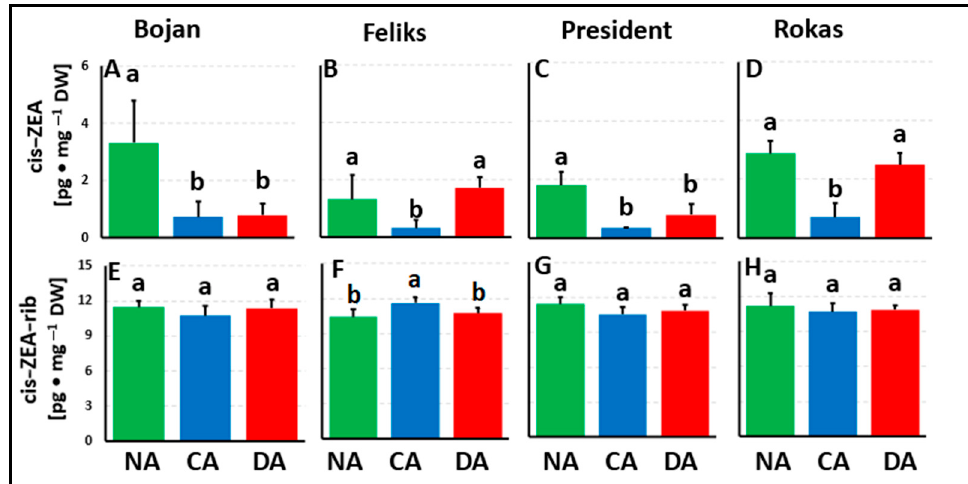
Figure 6. Content of the cytokinins–cis-zeatin (cis-ZEA) and cis-zeatin-riboside (cis-ZEA-rib) in four cultivars of the non-acclimated (NA), cold-acclimated (CA) and deacclimated (DA) oilseed rape. ( A – D )—cis-ZEA; ( E – H )—cis-ZEA-rib. Values marked with the same letters (within each cultivar separately) were not significantly different according to the Duncan test ( p ≤ 0.05).